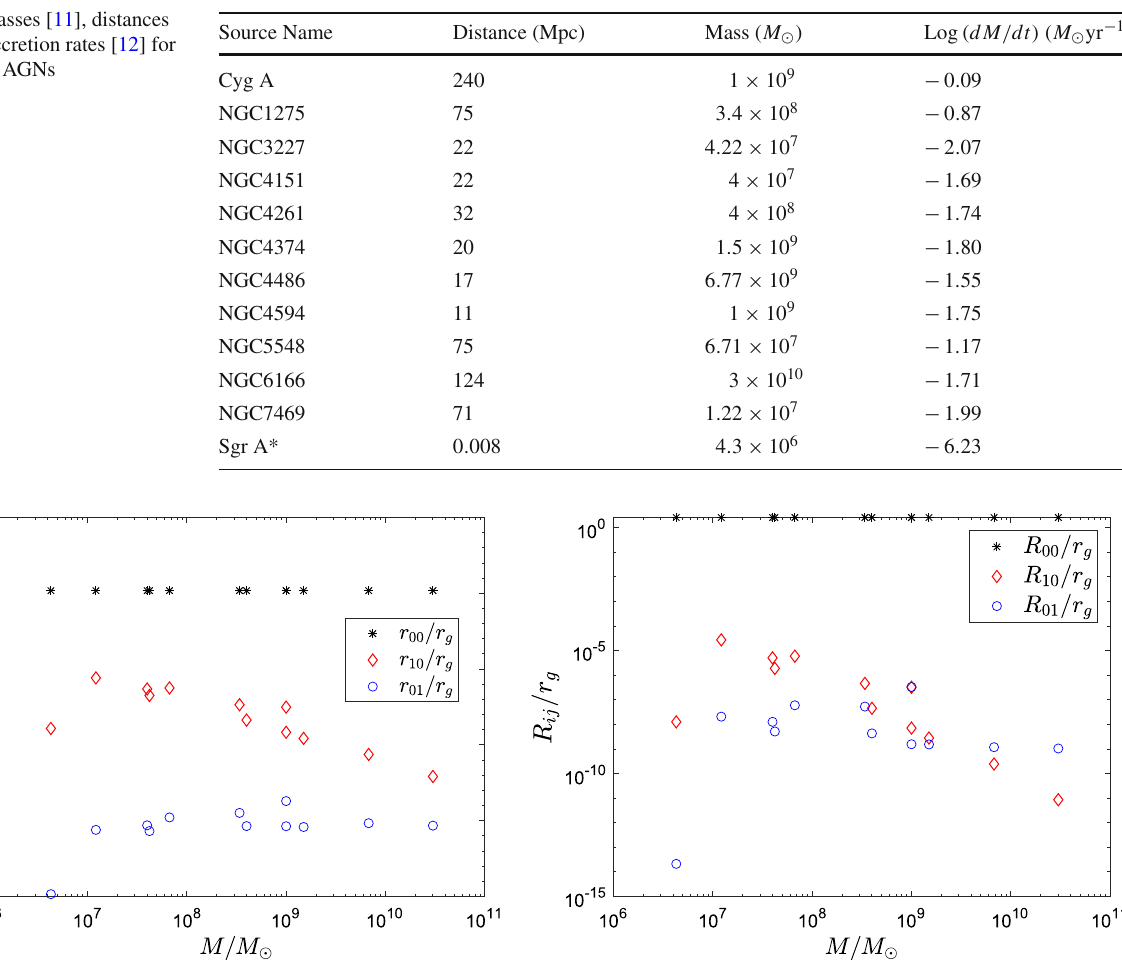
Eqs.(24),(25),(26)andTable1.Inbothpanels,blackasterisksrepresent the uncorrected radii, red diamonds denote the refractive corrections, and blue circles mark the gravitational